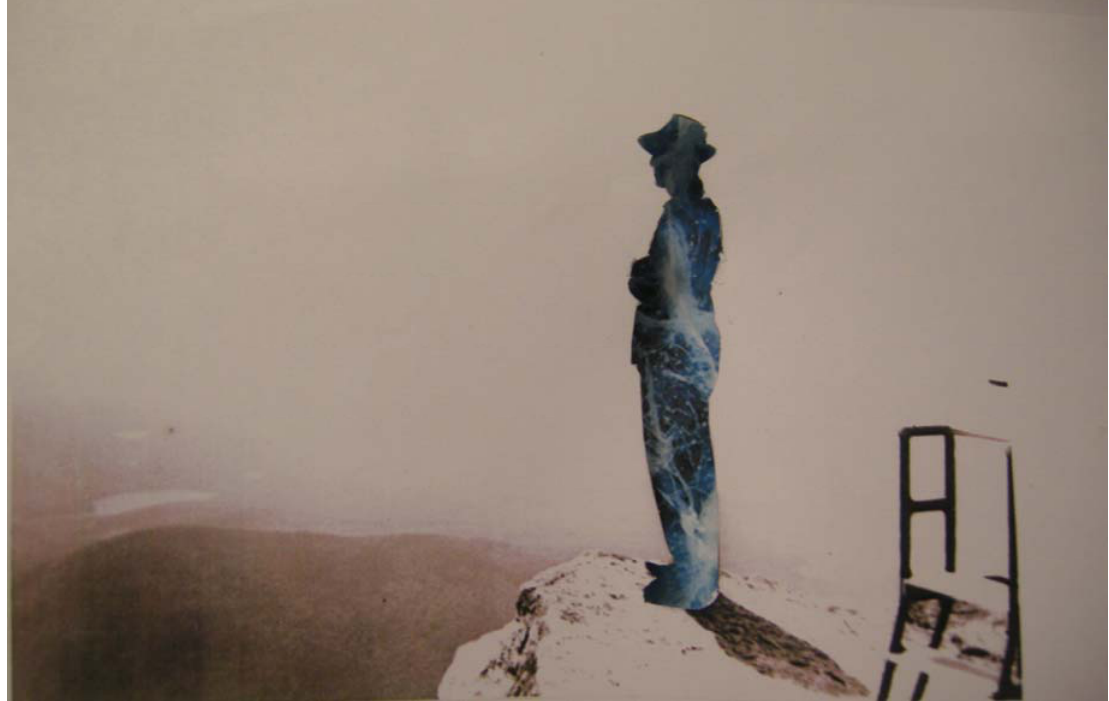
Figure 1. Collage from photograph of Peter Clapps, authors’ father and grandfather, on his